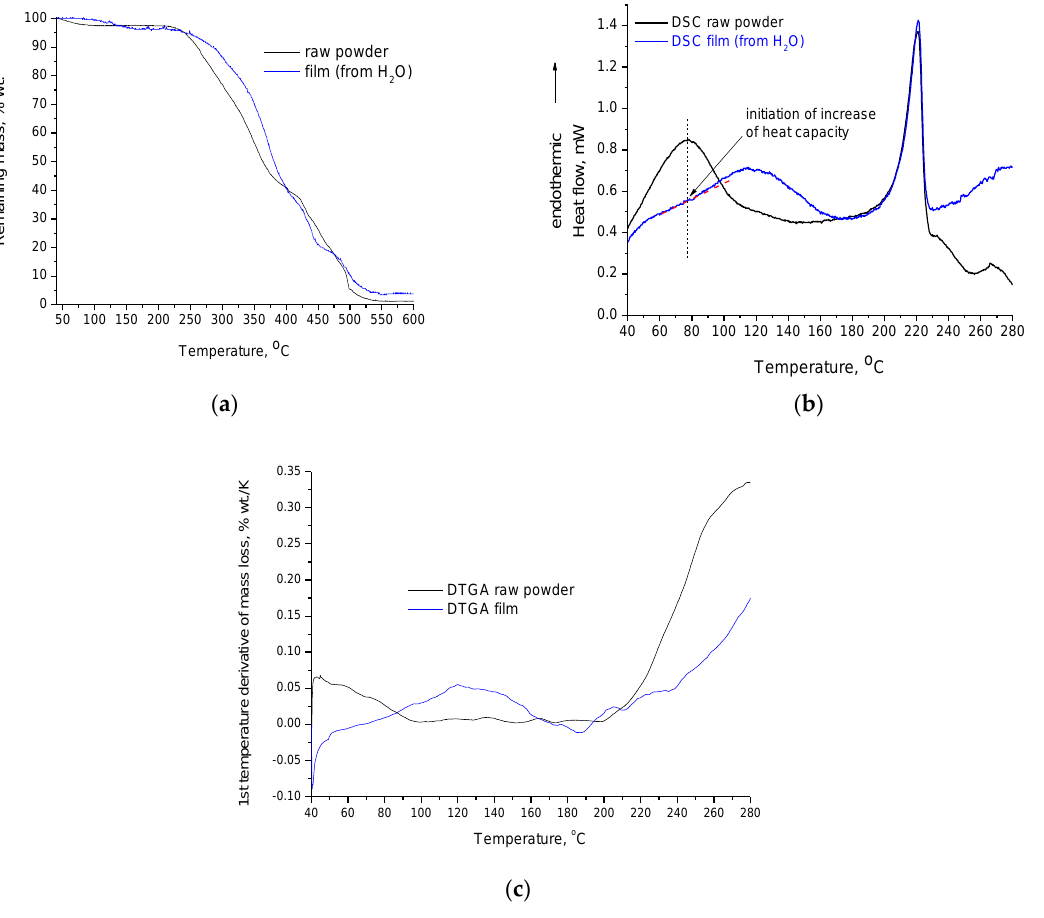
Figure 3. ( a ) TGA curves of PVA raw powder and PVA crosslinked film; ( b ) DSC curves of PVA raw powder and PVA crosslinked film (the pink and black dashed lines have been drawn to enable the visualization of the increase of the heat capacity); ( c ) First temperature derivative of the mass-loss curves (DTGA) of PVA raw powder and PVA crosslinked film.